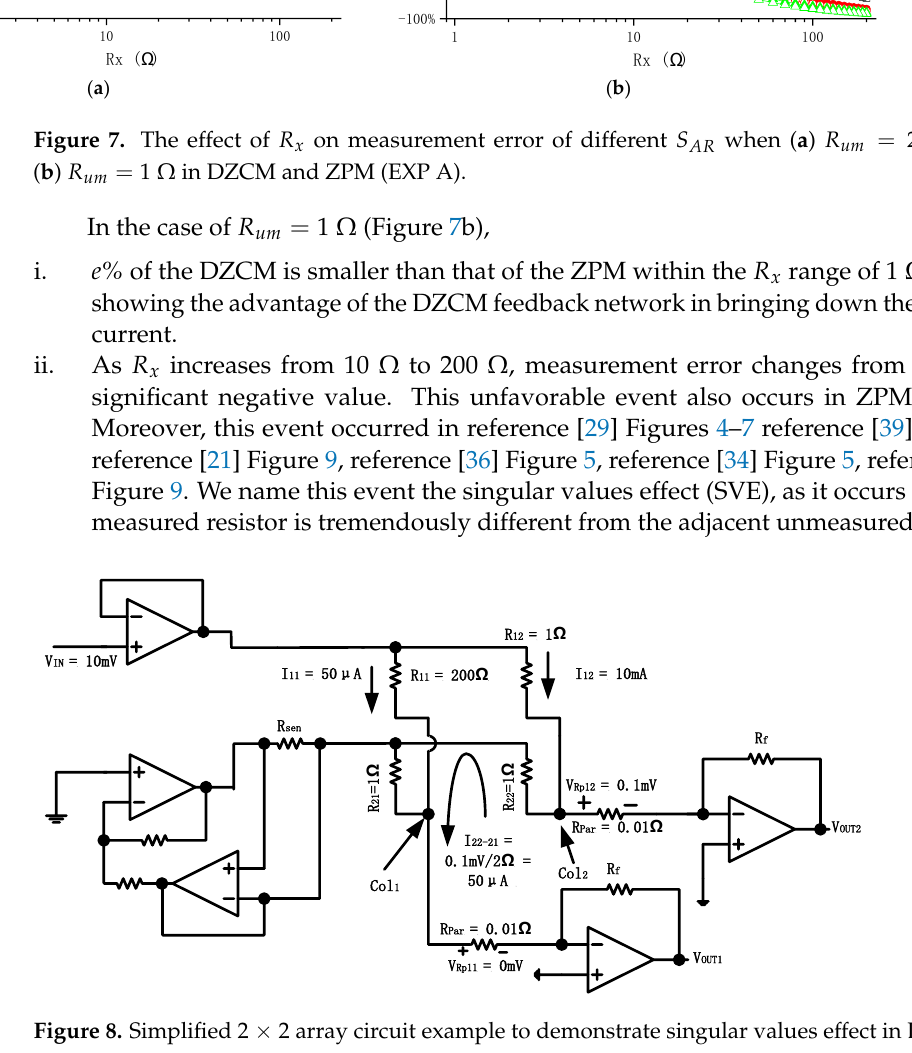
Figure 9. The effect of 𝑅 𝑥 on measurement error of different 𝑅 𝑢𝑚 when 𝑆 𝐴𝑅 = 2 × 2 in DZCM and ZPM (EXP B). A simple 2 × 2 array (see Figure 8) is illustrated to explain the SVE. Based on Figure 8, in the extreme case of 𝑅 𝑥 = 𝑅 11 = 200 Ω , current flowing through 𝑅 11 decreases, de- noted by 𝐼 11 = 𝑉 𝑖𝑛 𝑅 𝑥 ⁄ = 10 mV 200 Ω⁄ = 50 μA . Meanwhile, for the adjacent resistor on the same row, 𝑅 12 = 1 Ω . The current through 𝑅 12 , represented by 𝐼 12 , is equivalent to 𝑉 𝑖𝑛 𝑅 𝑢𝑚 ⁄ = 10 mV 1 Ω⁄ = 10 mA . Our measurement shows that the parasitic resistances resulting from the cable linking the sensor to PCB are 𝑅 𝑝𝑎𝑟 = 0.01 Ω and the voltage at column 2 is 𝑉 𝐶𝑜𝑙2 = 10 mA × 0.01 Ω = 0.1 mV , and the voltage at column 1 is 𝑉 𝐶𝑜𝑙1 ≈ 0 mV . Due to this potential difference between 𝑉 𝐶𝑜𝑙1 and 𝑉 𝐶𝑜𝑙2 , there will be a crosstalk current through 𝑅 22 and 𝑅 21 , 𝐼 22−21 = 0.1 mV 2⁄ Ω = 50 uA . As 𝐼 22−21 are in the same order as 𝐼 11 , the measurement error can add up to 100%. Figure 7 also shows the improvement of the DZCM in reducing measurement error in the range of 1 Ω < 𝑅 𝑥 < 10 Ω and 𝑅 𝑢𝑚 = 1 Ω . That is to say, in low resistance RSA, the DZCM is capable of decreasing the measurement error. EXP B: As shown in Figure 9, the e% of the DZCM is smaller or similar to the ZPM in the range of 1 Ω < 𝑅 𝑥 < 10 Ω . This measurement error in the DZCM becomes larger than the ZPM as 𝑅 𝑥 increases to the range of 10 Ω < 𝑅 𝑥 < 200 Ω , the increment has been ex- plained in EXP A above as SVE. EXP C: As shown in Figure 10a,c,e, when 𝑅 𝑝𝑎𝑟𝑅𝑜𝑤 (the parasitic resistor of row wires) changes from 0 Ω to 3.5 Ω and 𝑅 𝑢𝑚 = 𝑅 𝑥 = 1 Ω, 50 Ω, 200 Ω , the 𝑅 𝑥 error of the ZPM is the same as in the DZCM. 1